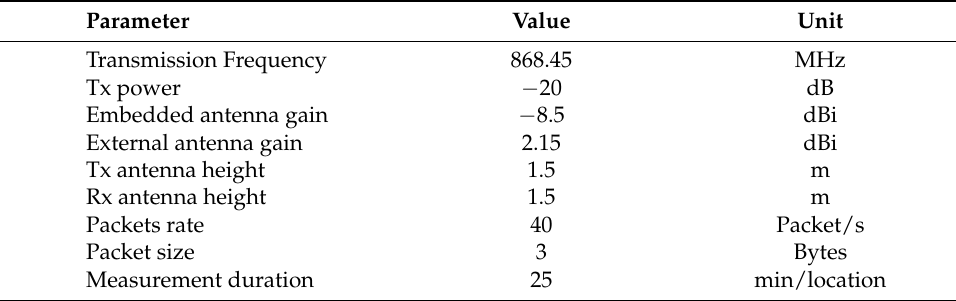
Table 5. Measurement setup